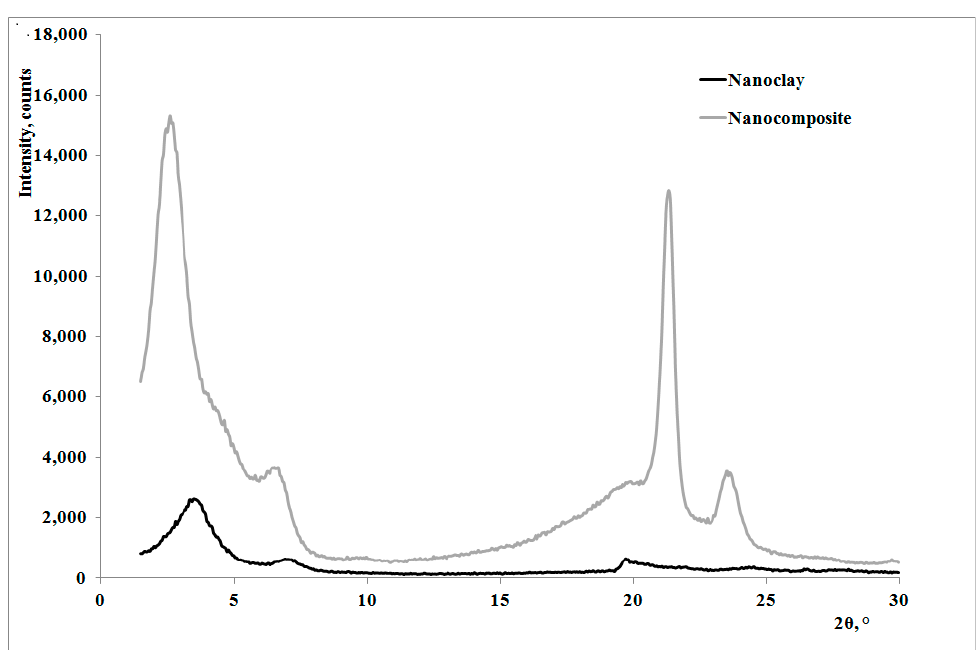
Figure 2. XRD traces of the nanoclay and the nanocomposite.